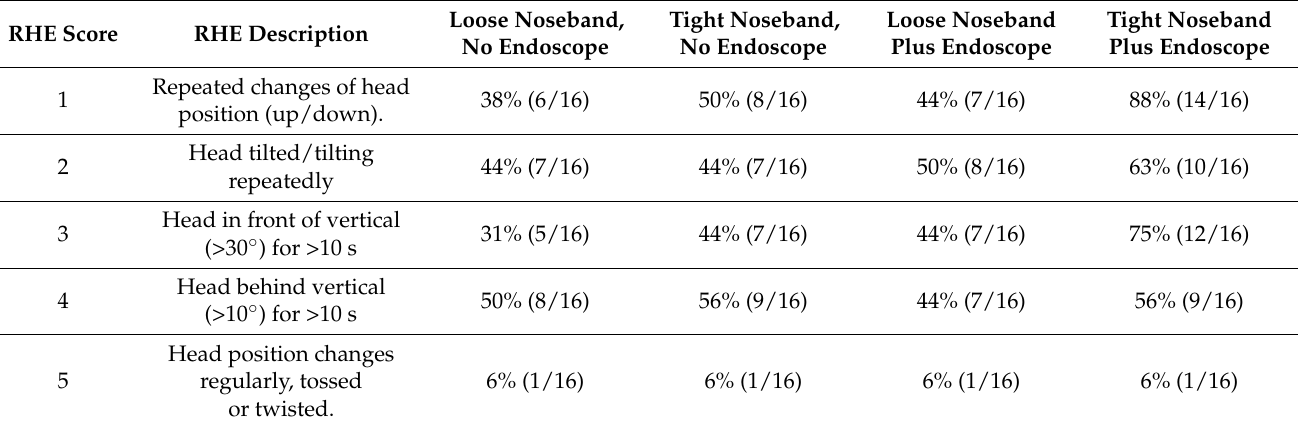
Table 3. RHE behavior (1–10) shown by the horses in the different settings (n = 16), regardless of the frequency of the behavioral changes in the respective